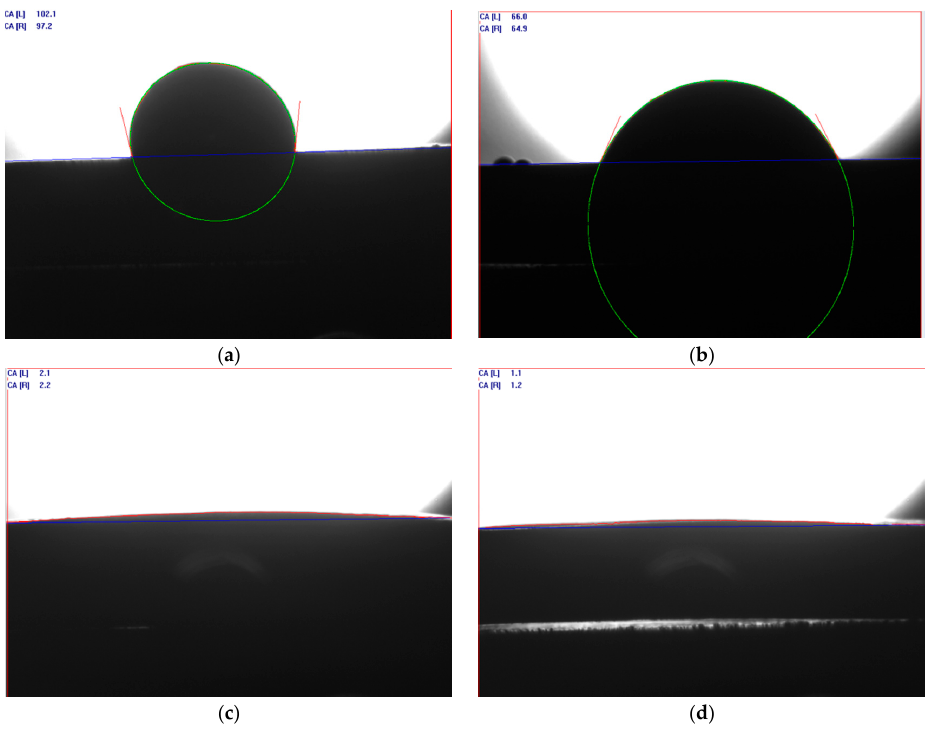
Figure 5. Wetting angle test results: ( a ) SnO 2 ; ( b ) SnO 2 -F; ( c ) SnO 2 -Cu; ( d ) SnO 2 -Cu-F. Table 5. The wetting angles between different doping systems and Ag liquid.